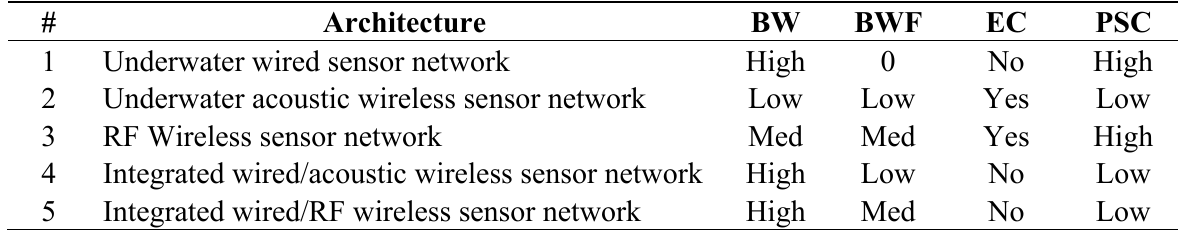
Table 2. A Summary of the reliability issues for different sensor network architectures for underwater